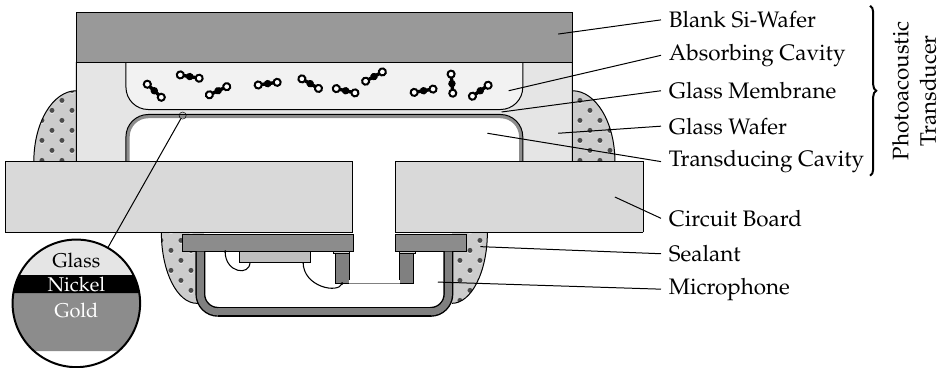
Figure 2. Proposed detector element comprising the photoacoustic transducer, a microphone, sealant compounds and a carrier PCB (not to